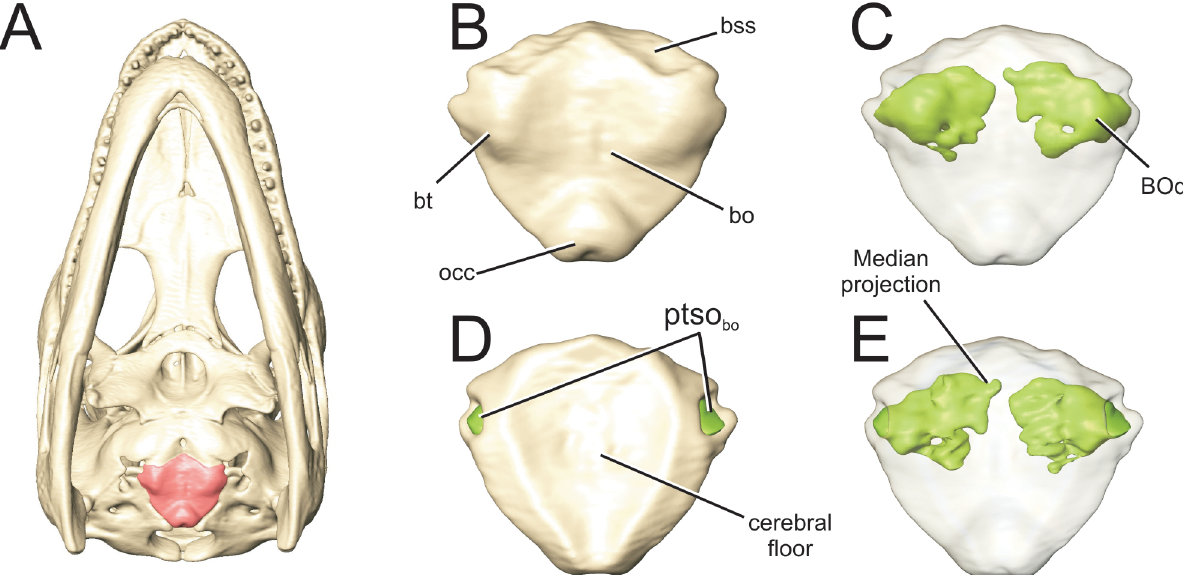
Fig 7. Perinatal Alligator mississippiensis (OUVC 10606) shown in A) ventral aspect with the basioccipital in red. Isolated basioocipital shown in B) ventral aspect and C) rendered transparent with the basisoccipital diverticulum rendered in green. And in D) dorsal aspect and E) rendered transparent with the basioccipital diverticulum rendered in green. bo , basioccipital; BOd , basioccipital diverticulum; bss, basisphenoidal suture; bt , basal tuber; occ, occipital condyle; ptso bo , communicating ostium between pharyngotympanic sinus and basioccipital